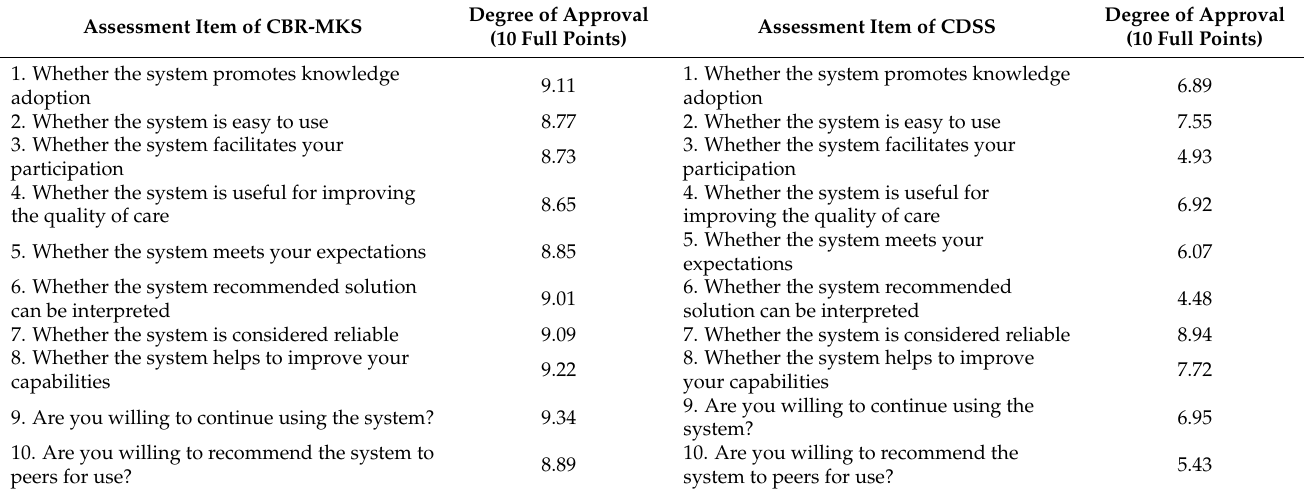
Table 1. Average evaluation results of CBR-MKS and